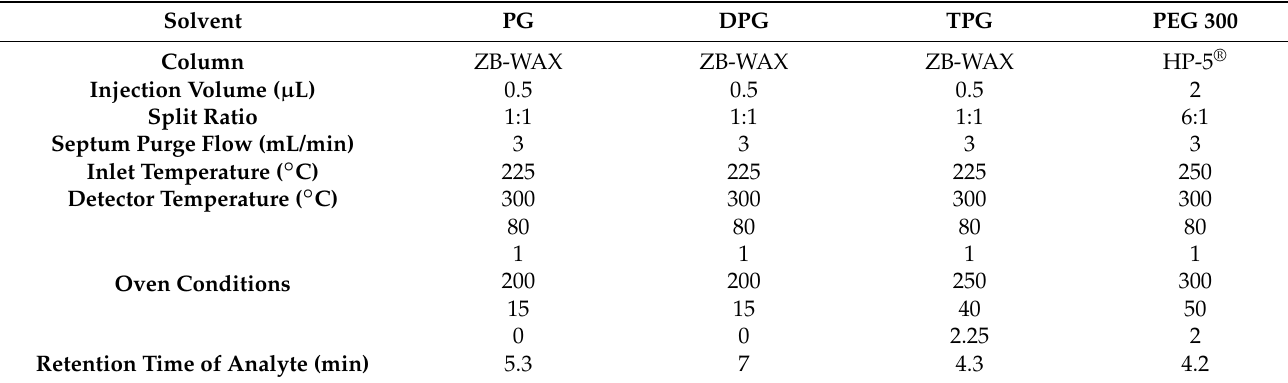
Table 1. Gas chromatography (GC) analytical parameters for solvents.